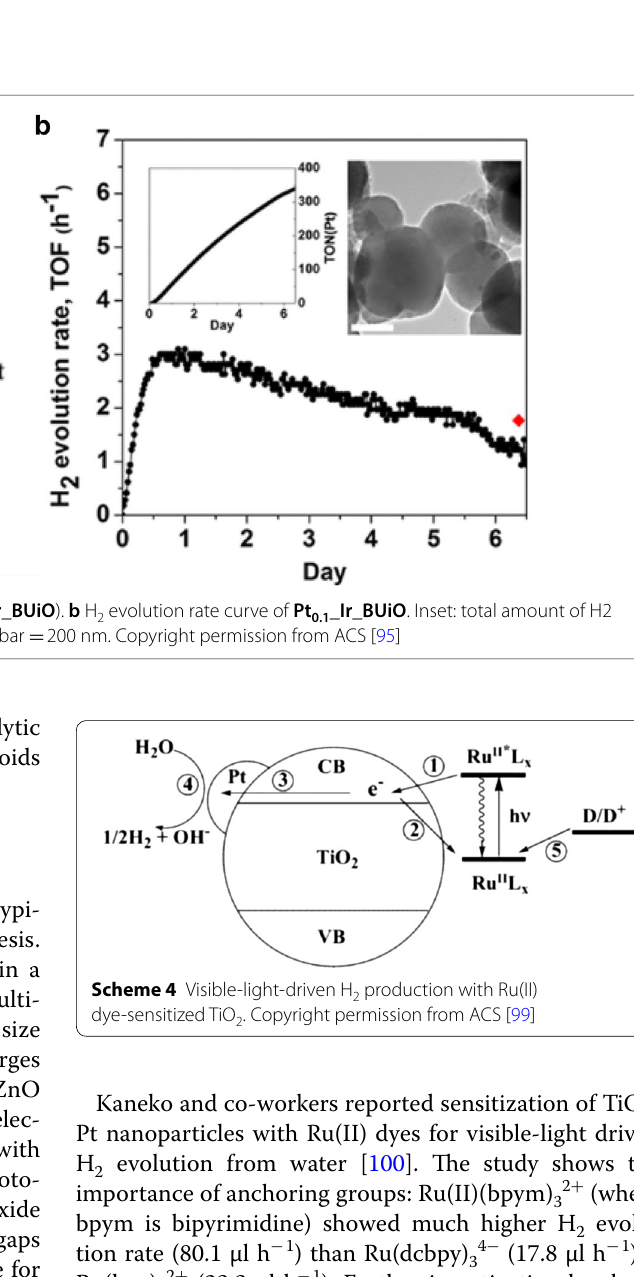
Scheme 4 Visible-light-driven H 2 production with Ru(II) dye-sensitized